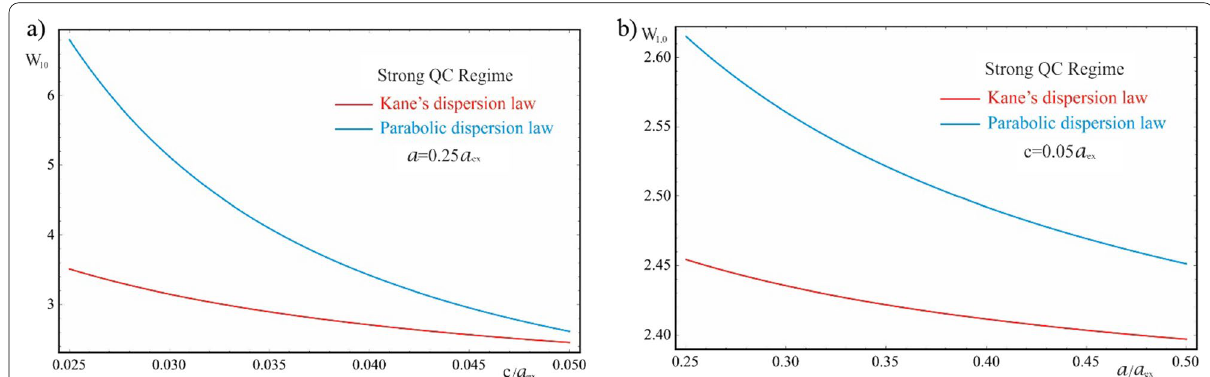
Fig. 12 The dependences of the AE for Kane’s and parabolic dispersion laws of CCs in the strong quantum confinement regime: ( a ) on the minor semiaxis c at the fixed value of the major semiaxis a , ( b ) on the major semiaxis a at the fixed value of the minor semiaxis c